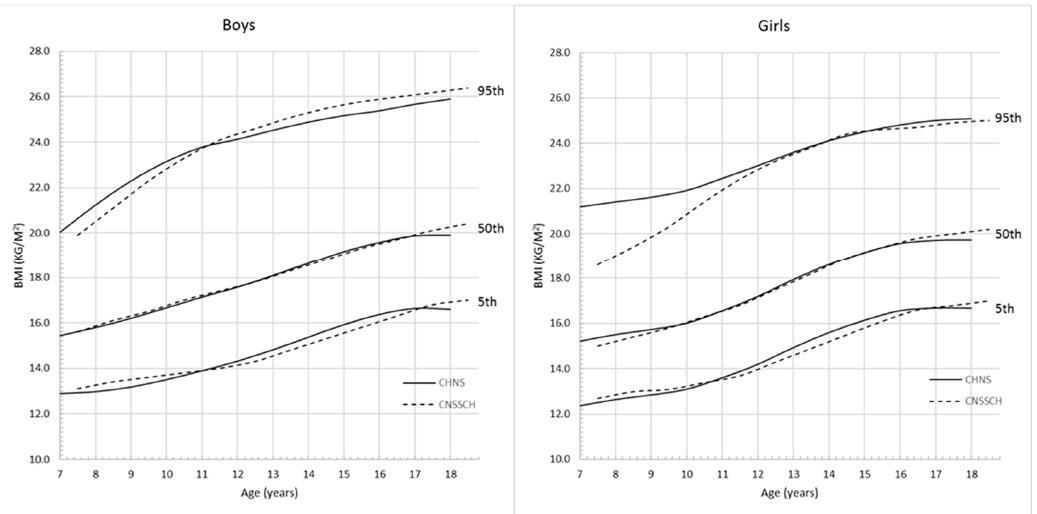
Figure 4. Comparison of the CHNS and CNSSCH BMI percentile curves for Chinese boys and girls aged 7–18 years.